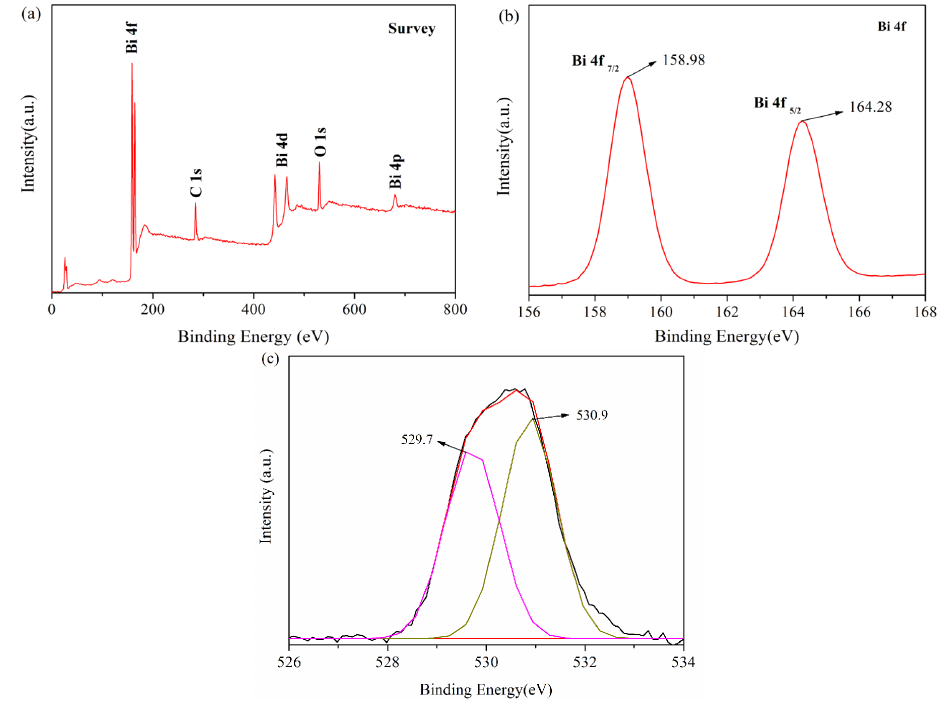
Figure 5. ( a ) XPS spectrum of BC ‐ 873 ‐ 5; High ‐ resolution XPS spectra of ( b ) Bi 4 f and ( c ) O 1 s in BC ‐ 873 ‐ 5.